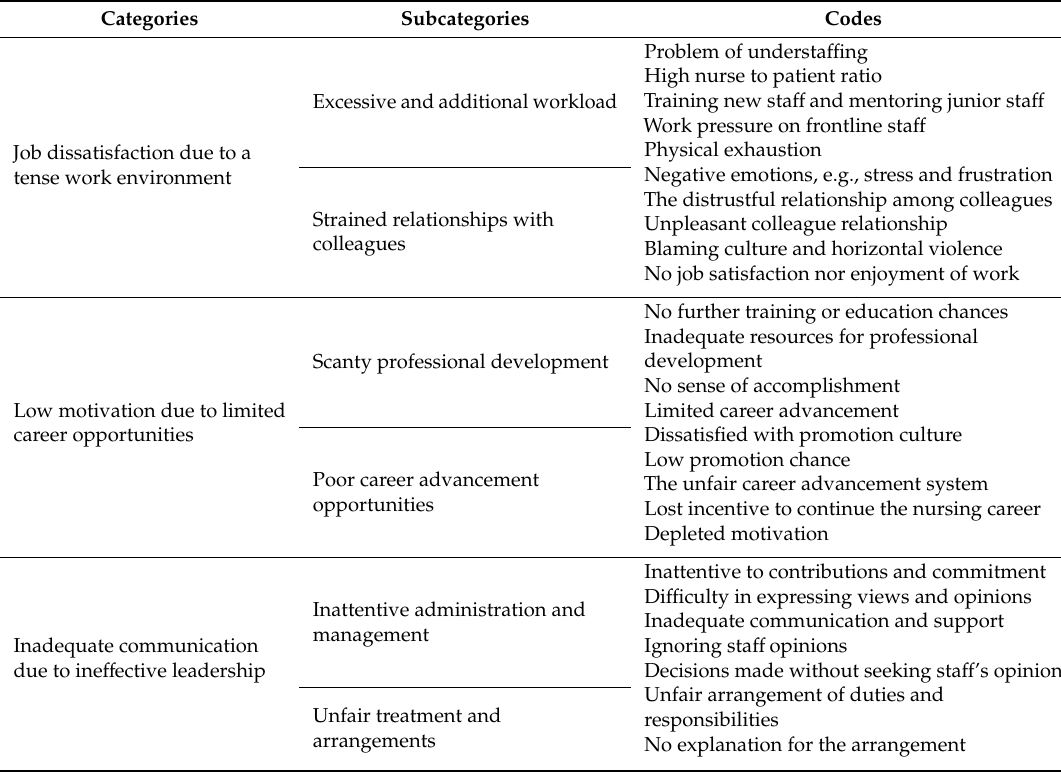
Table 2. The categories, the subcategories, and the